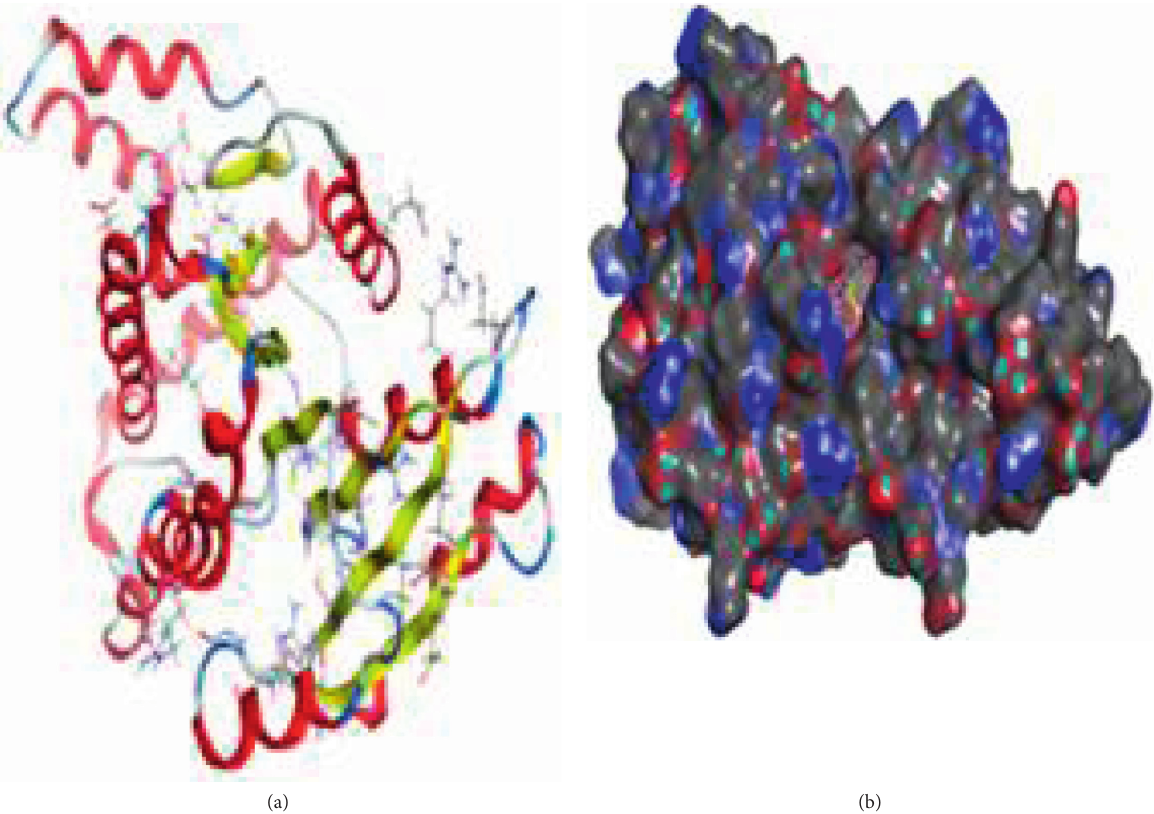
(a) (b) Figure 7: (a) 3D molecular interaction of DMPTHP for inhibition to 3HB5 protein of Homo sapiens . (b) 3D molecular interaction of DMPTHP for inhibition to 3HB5 of Homo sapiens inside the core on the protein surface. Table 6: Protonation constants for the DMPTHP ligand and stability constants for the Zn(II) and Cd(II) complexes with the DMPTHP ligand at 0.1mol · L − 1 NaNO 3 at different temperatures.